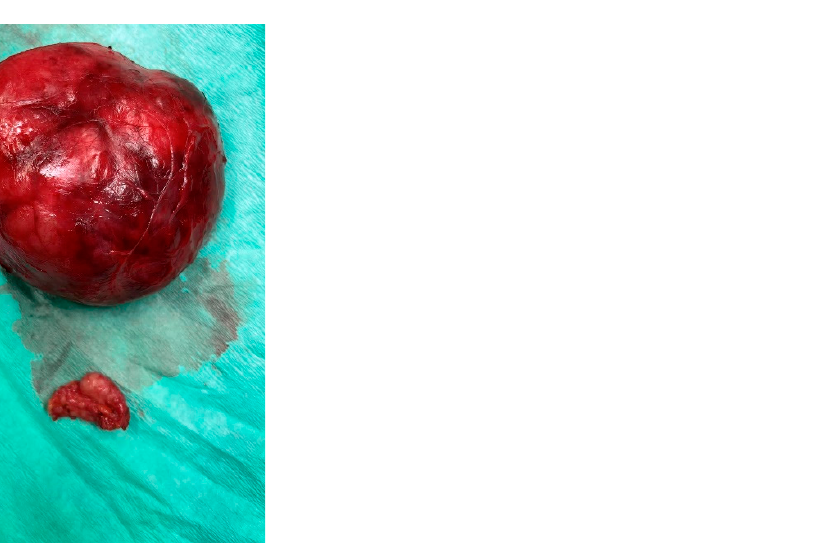
Figure 4. Surgical specimen of the excised mass with dimensions 10 cm × 8 cm × 2.5 cm. Table 1. Characteristics of the cases of juvenile fibroadenomas, identified through an extensive PubMed search.